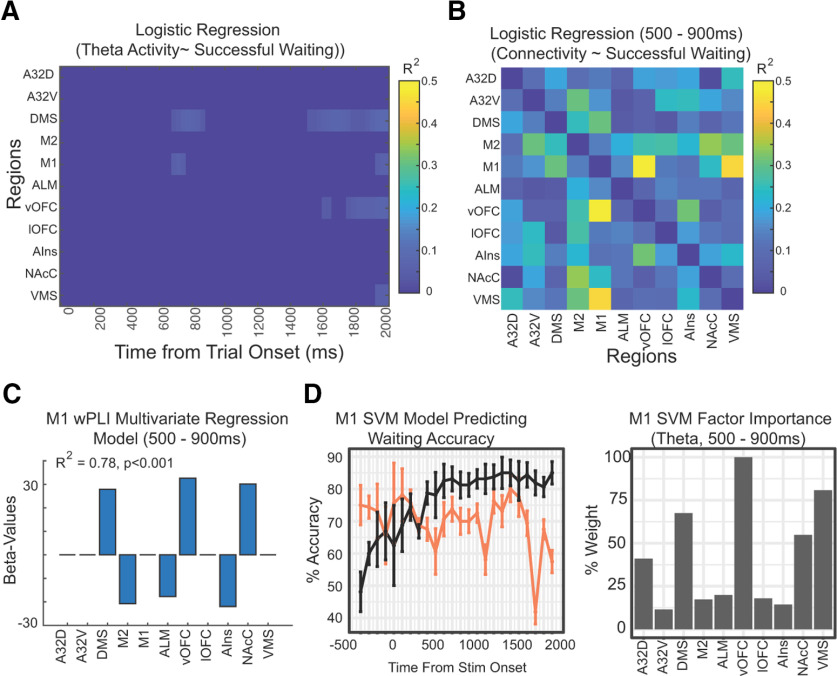
Correlation between network connectivity and successful inhibition. A, Logistic regression was performed over time between θ activity (averaged for successful vs unsuccessful wait trials) and trial-type from each of the behavioral sessions (FDR-corrected/thresholded across all electrodes/time). We plotted activity in 11 selected regions showing strong θ activity or connectivity. We found significant activity in DMS and M1 correlated with successful inhibition but relatively weakly. B, We performed a similar analysis using wPLI values averaged in an early period (between 500 and 900 ms after stimulus onset, FDR-corrected). We found highly significant and strong correlations with behavior using pair-wise connectivity. M1-OFC connectivity shows a strong and significant relationship with behavior. C, Multivariate regression model was developed with connectivity from M1 to the 10 other brain regions (only significant β values in the model shown), demonstrating that connectivity with ventral striatum and OFC are associated with improved impulsivity while connectivity with motor regions are associated with diminished impulsivity. Overall, multivariate regression model shows a strong relationship with behavior, demonstrating that connectivity can be used to accurately classify trial types. D, We next used an SVM ML model to measure classification of trial types using M1 connectivity at each time point for both θ and β activity. Model used a 75%/25% split (training vs test) with 10× cross-validation, and we randomized the initial 75/25 split ten times to produce a mean/SEM of the model. We performed this for wPLI from M1 for both theta (black) and Beta (orange) values. We found that the θ model achieves >80% performance by 500 ms poststimulus. We plotted the SVM Factor importance for the ML model (using time-points between 500-900ms post stim). We found connectivity values from vOFC, nAcC, VMS, DMS and A32D were particularly important in the prediction model.